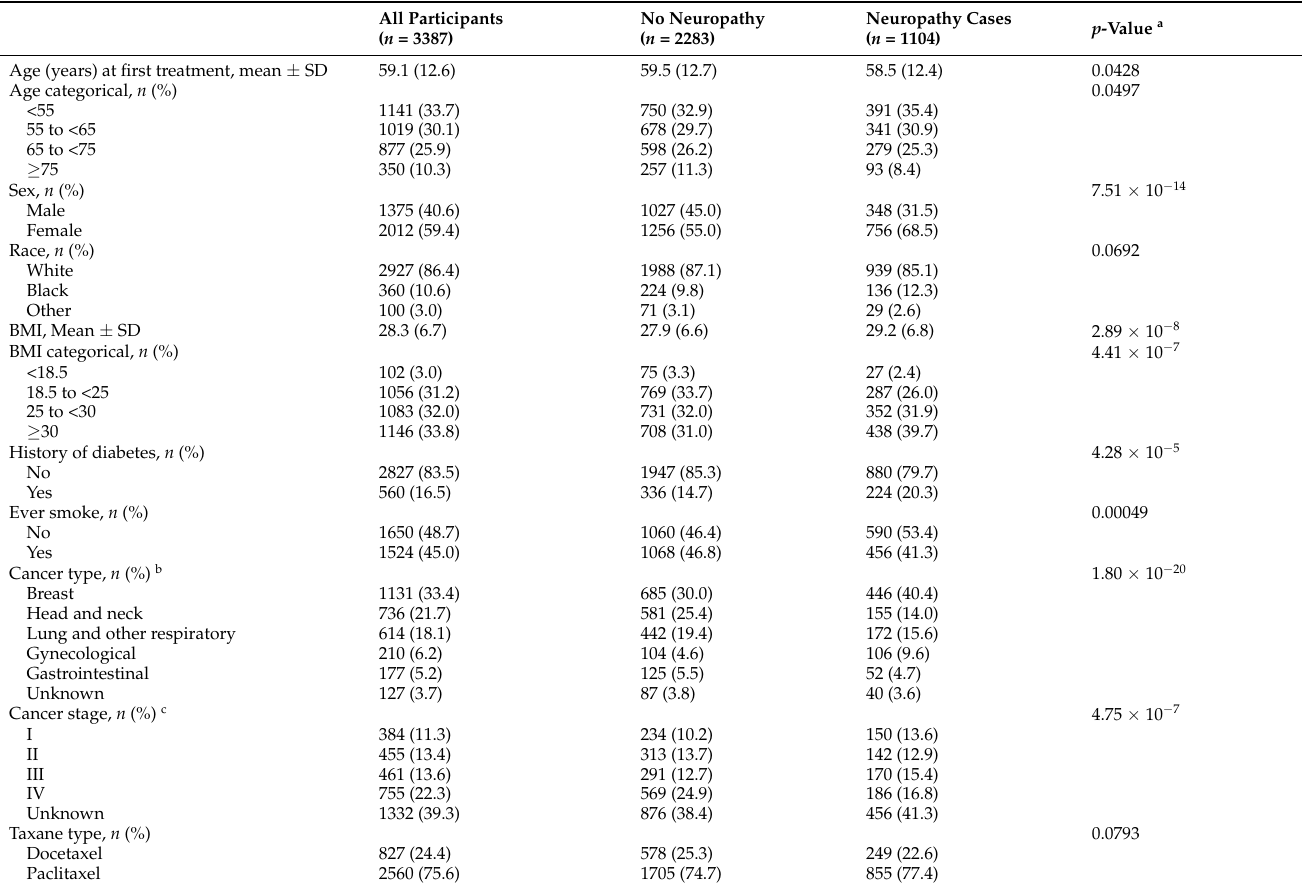
Table 1. Prevalence of neuropathy by patient demographic and clinical characteristics. All Participants ( n =